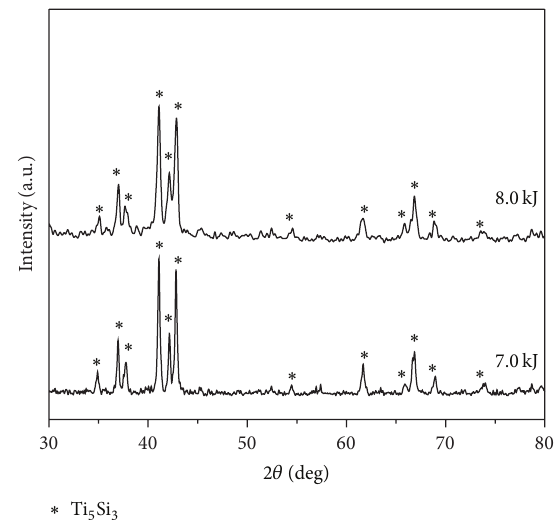
Figure5:XRDpatternsoftheTi 5 Si 3 compactsobtainedbyelectrical discharge consolidation of MAed Ti 5 Si 3 powder using 7.0 and 8.0 kJ of input